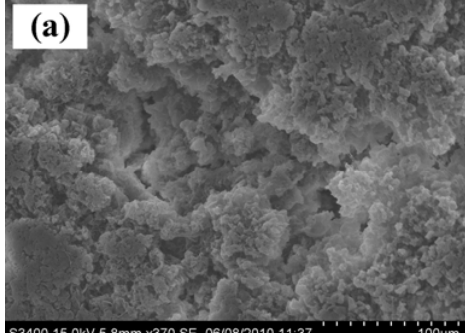
(centroid)-M-C -(centroid) in p p